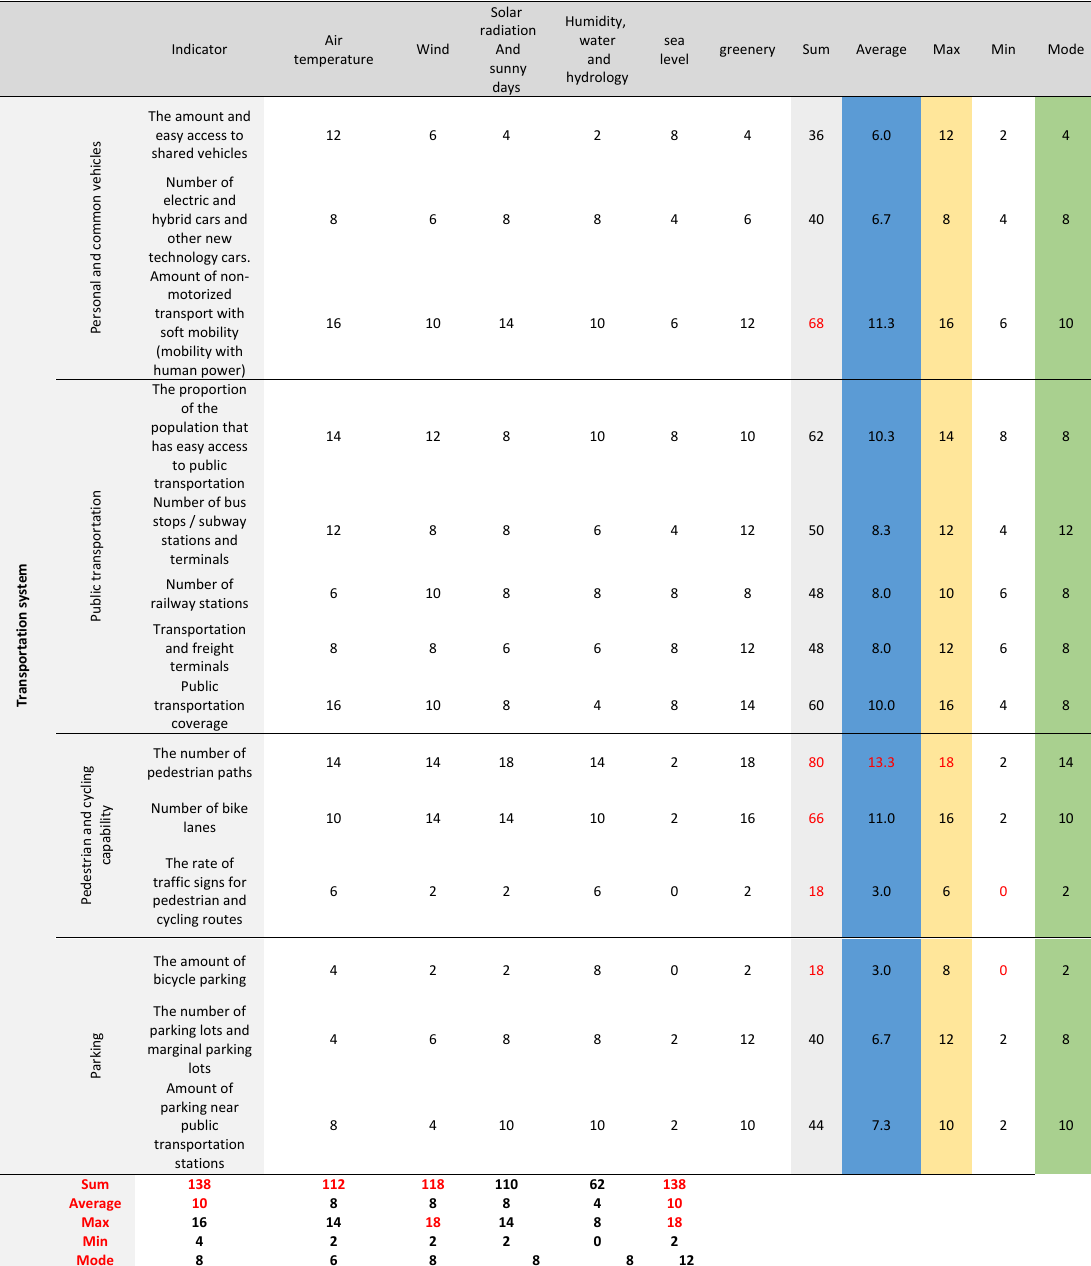
Table 8: Relation between transportation system and climate indicators